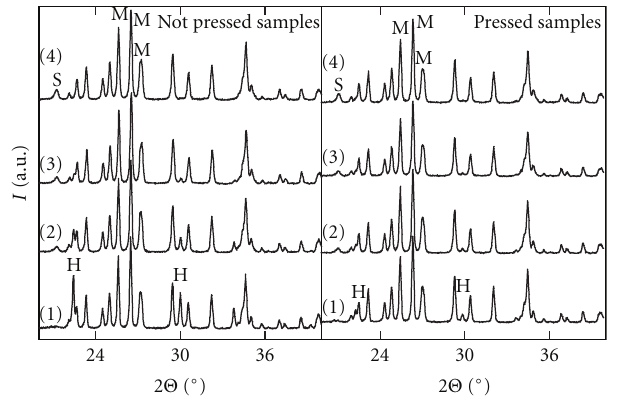
Figure 3: XRD patterns of powder-like samples 1, 2, 3, and 4 and of materials obtained by grinding pellets manufactured by pressing samples 1, 2, 3, and 4 at 30MPa, thermally treated at 1300 ◦ C for 5 hours (M = monoclinic celsian, H = hexacelsian, S = sodium aluminosilicate).